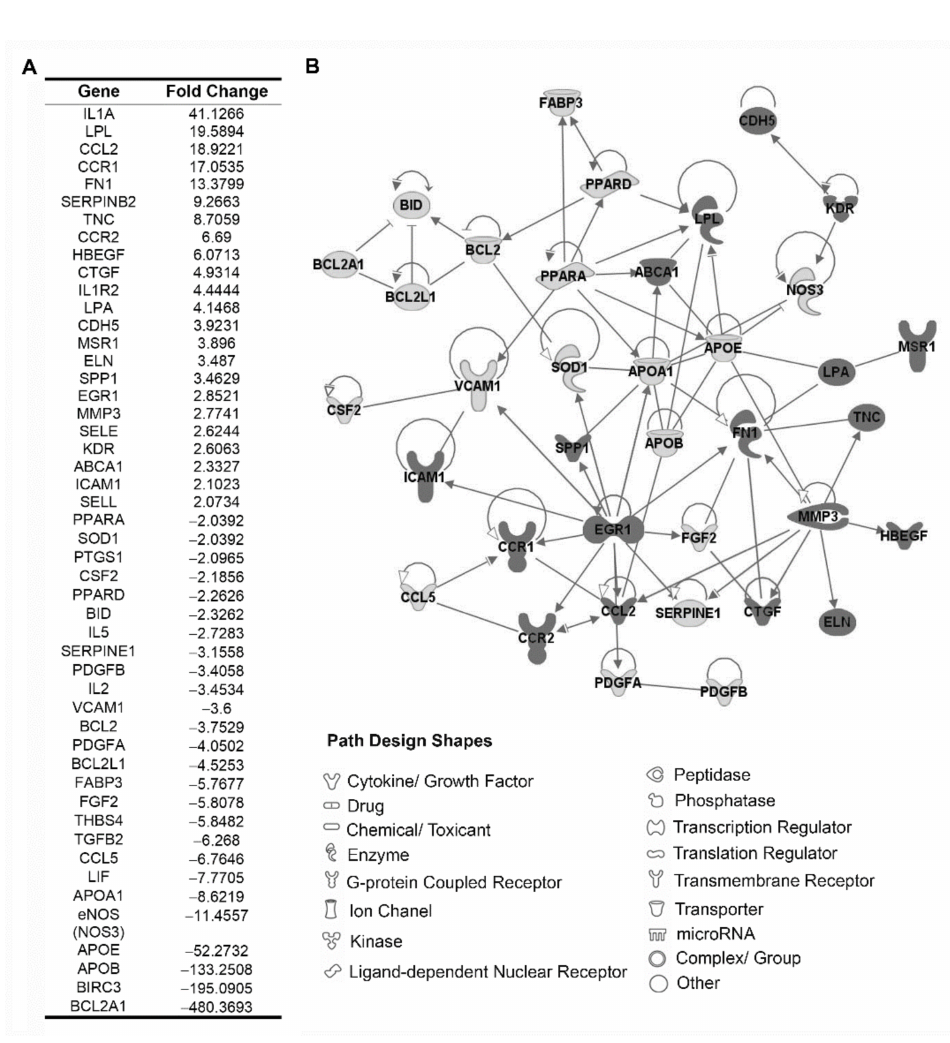
Figure 1. Atherogenic expression profile in PBMCs using atherosclerosis RT2 Profiler PCR array. ( A ) Fold change of 49 differentially expressed genes ( ≥ 2) between PBMCs from r-axSpA patients and HDs after normalization of the raw data. ( B ) Gene network between the modulated genes in r-axSpA patients. PBMCs, peripheral blood mononuclear cells; HDs, healthy donors; r-axSpA, radiographic axial